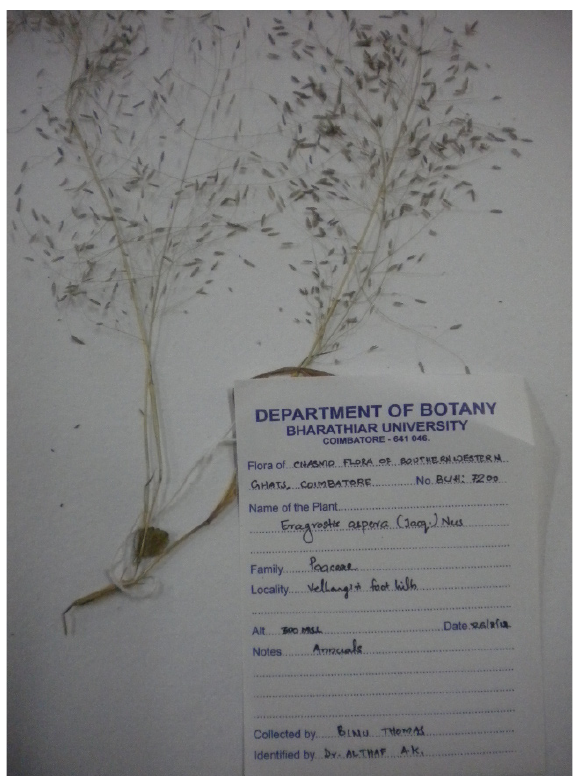
Image 16. Eleusine indica (L.) Gaertn.